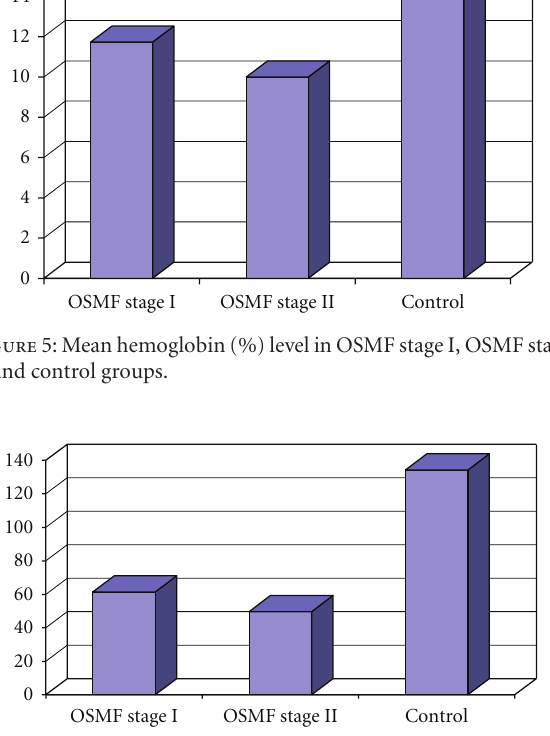
Figure 6: Mean serum iron level in OSMF stage I, OSMF stage II and control